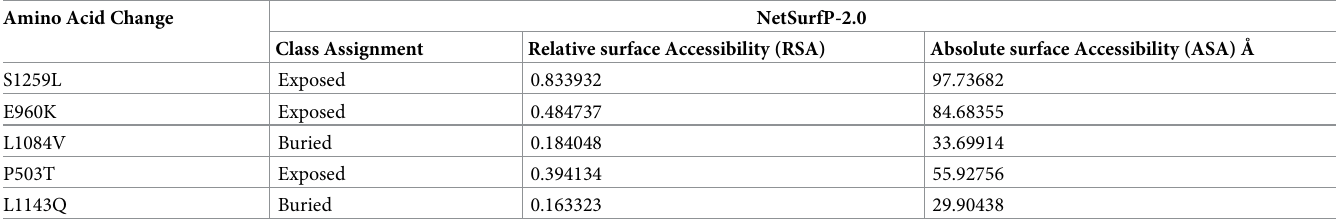
Table 3. Prediction of surface accessibility by